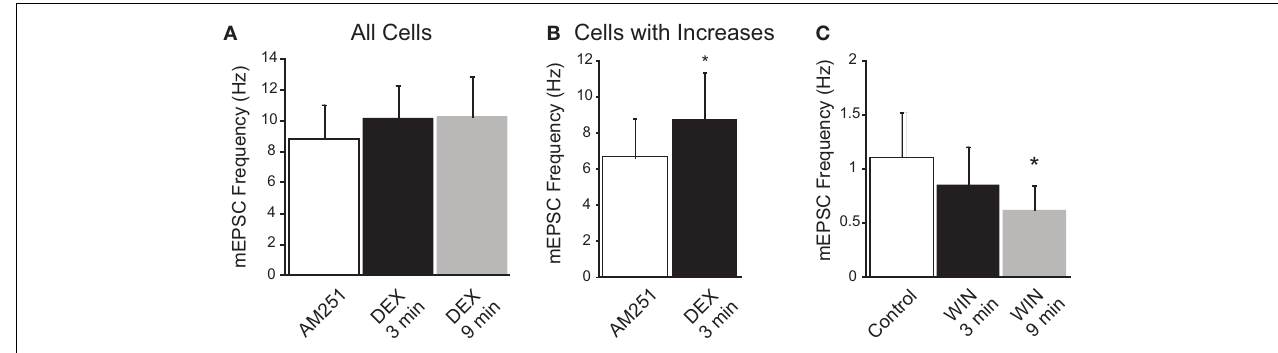
frequency change in cells in which an increase in mEPSC frequency was detected ( n = 4; * p < 0.05, t -test). (C) The synthetic cannabinoid agonist,WIN 55,212-2 (WIN; 10 µ M) decreased the frequency of mEPSCs ( n = 8; * p < 0.05 from control; ANOVA,Tukey’s); an increase in mEPSC frequency was not observed at either the early or late time point in the presence